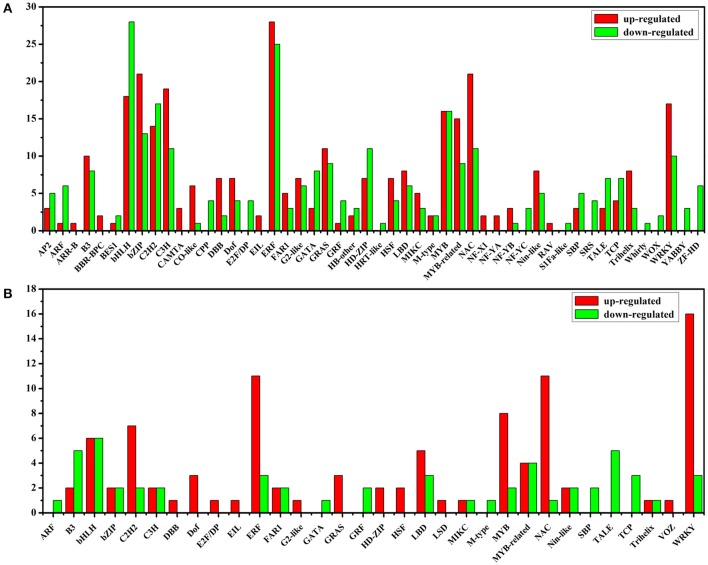
Up-regulated and down-regulated TFs between the Dark relative to Light (A) and Light-MeJA-4h relative to Light (B). The x-axis represents the name of TF families which contain differentially expressed TFs.